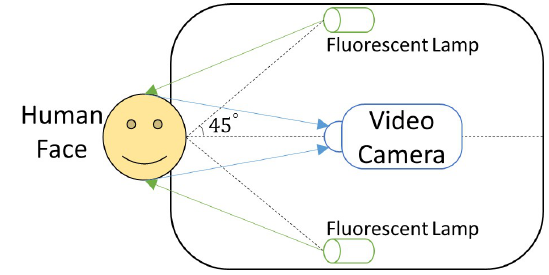
Figure 3. Facial image capture device light